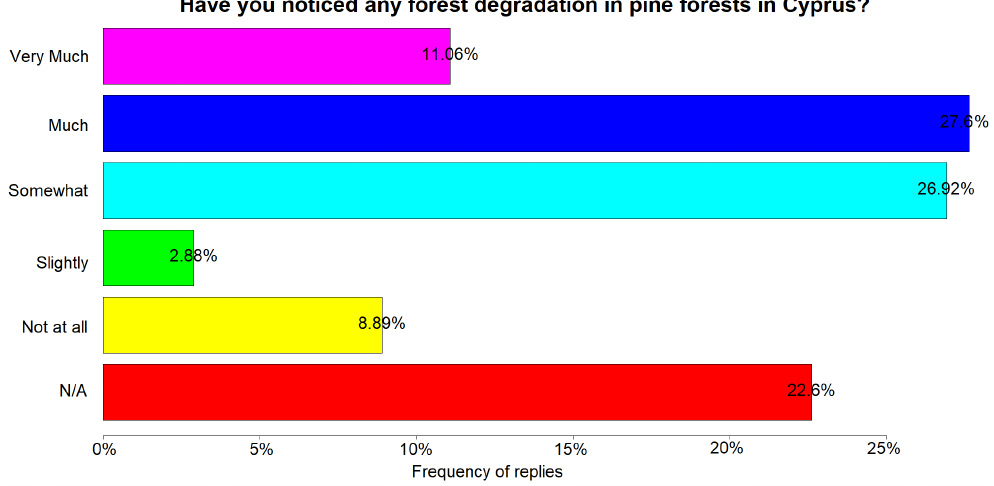
Figure 5. Answers to question: Have you noticed any forest degradation in pine forests in Cyprus (e.g., reduced forest density, forest-related diseases or